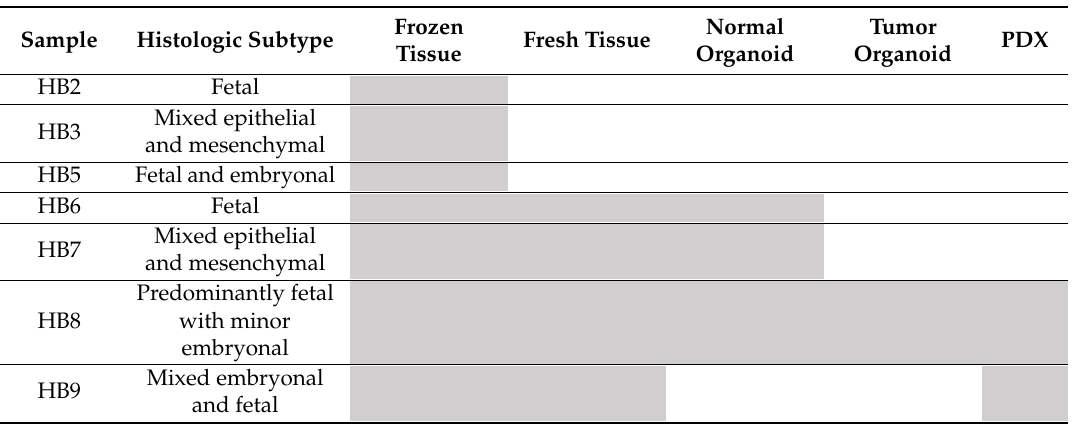
Table 1. Frozen tumor and surrounding normal tissue were collected from seven patients. The table shows the histologic subtypes of tumors included in the sample cohort, and the grey boxes indicate the material collected for each patient